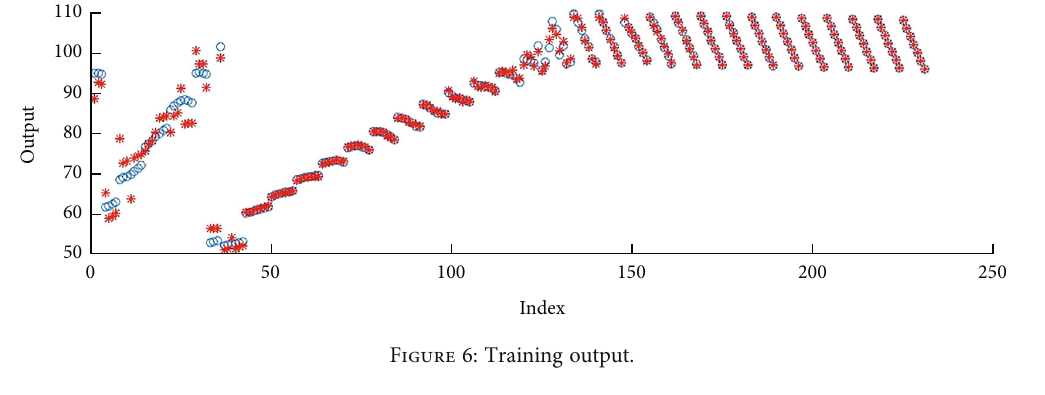
Figure 5: Training datasets.